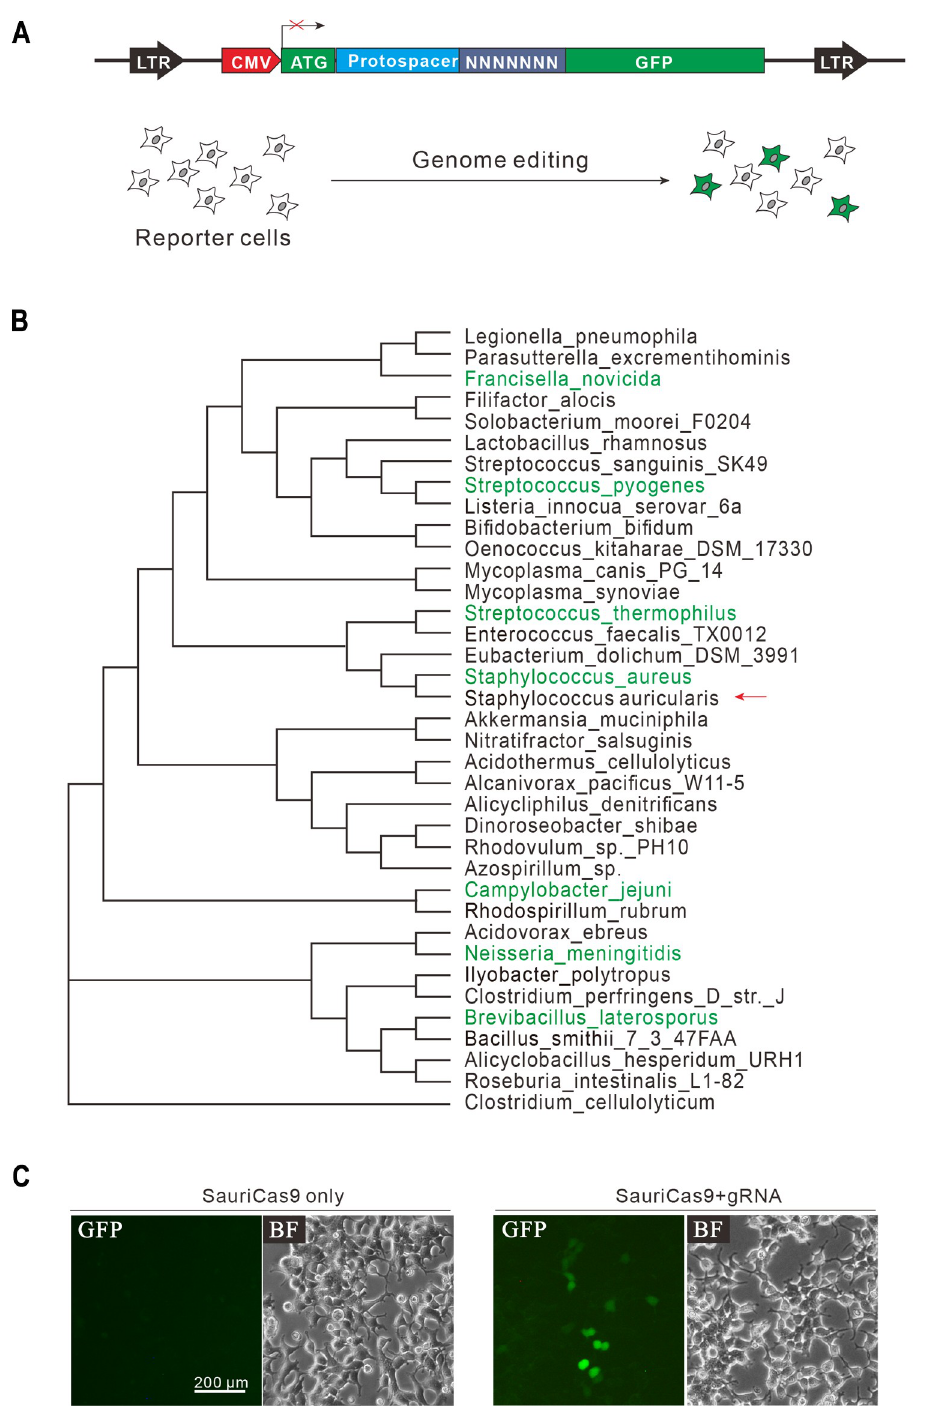
Fig 1. A GFP-reporter assay for Cas9 screening. (A) Schematic diagram of the GFP-reporter assay. A lentiviral vector containing a CMV-driven GFP, which is disrupted by an insertion of a target sequence followed by 7-bp random sequence between ATG and GFP coding sequence. The library DNA is stably integrated into HEK293T cells. Genome editing will induce GFP expression for a portion of cells. (B) Phylogenetic tree of selected Cas9 orthologs from different bacterial strains for activity screening. Seven validated Cas9 orthologs (green color) are used as reference. (C) Transfection of SauriCas9 with gRNA resulted in GFP expression, whereas transfection of SauriCas9 alone did not induce GFP expression. BF, bright field; CMV, cytomegalovirus; GFP, green fluorescent protein; gRNA, guide RNA; LTR, long terminal repeat; SauriCas9, Cas9 nuclease from S . auricularis .